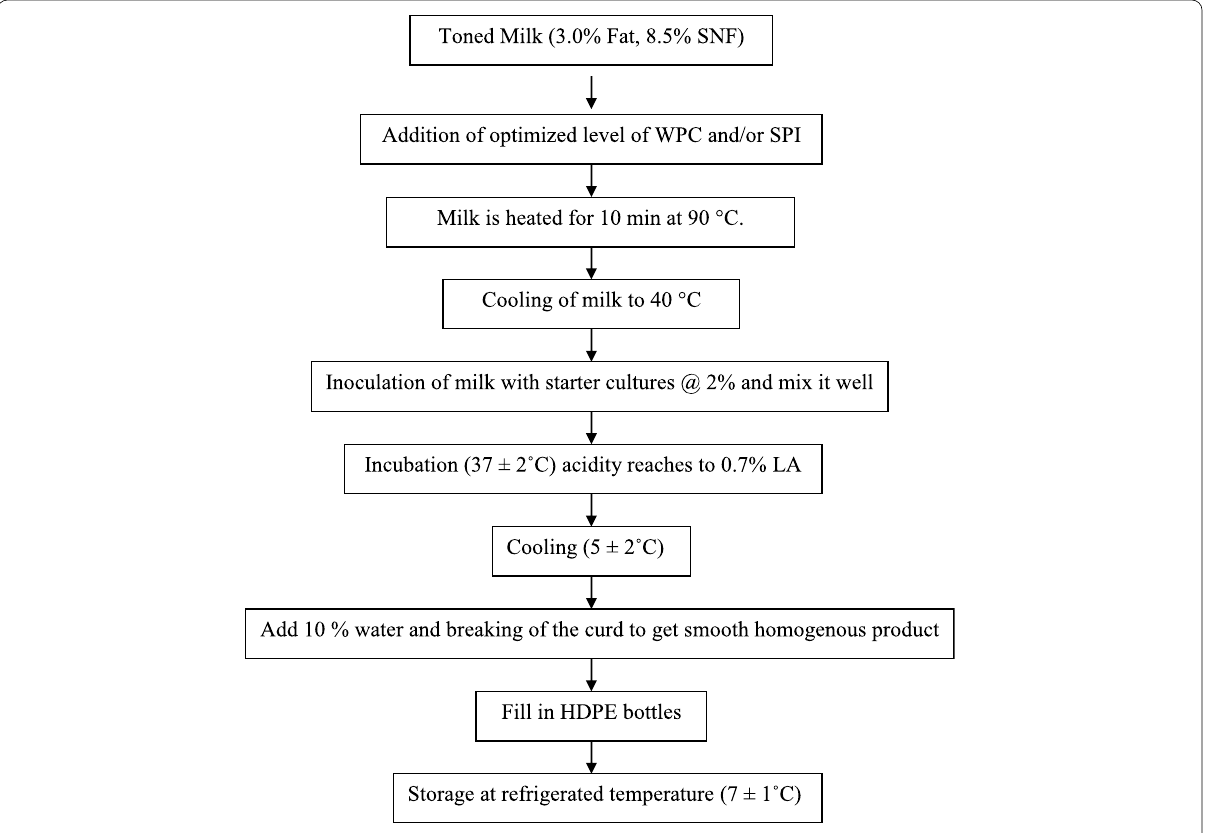
Fig. 1 Method used for the preparation of probiotic fermented